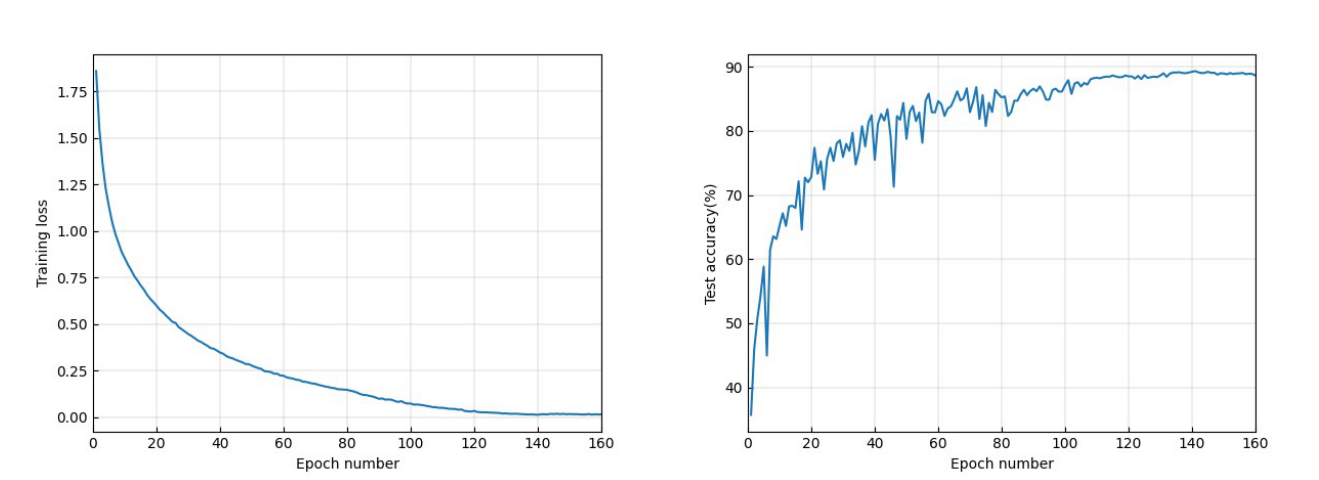
Figure A3. The over-fitted result obtained when training a toy CNN model on CIFAR-10. This CNN had 9 layers: the input layer, the convolution layer, a max-pooling layer, another convolution layer, another max-pooling layer, the flatten layer, 2 fully connected layers, and a softmax layer.